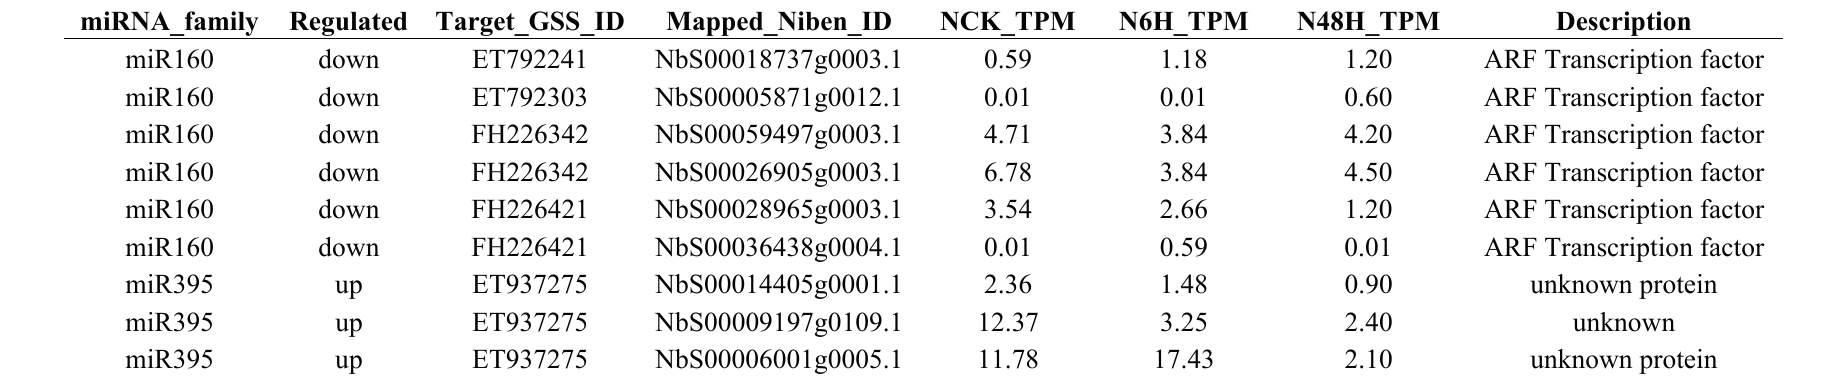
Table 2. Drought responsive miRNA families and their targets in